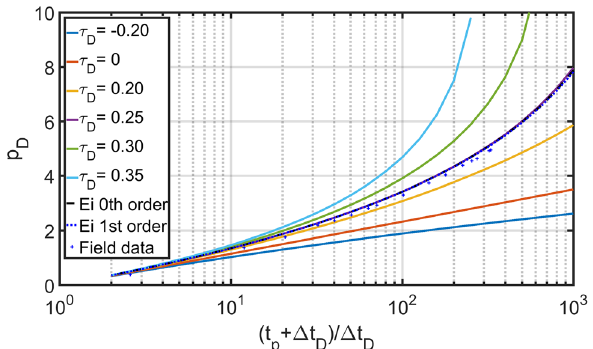
Fig. 1 Comparison of zero and first order perturbation, Horner ratio on the horizontal axis